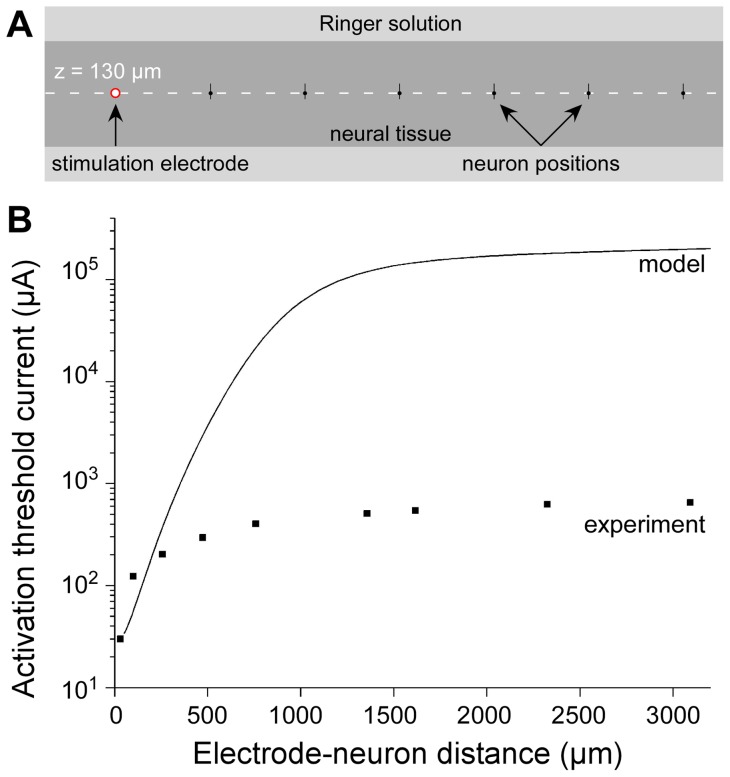
Modeling prediction of activation threshold currents.
A: Simulated TCs were computed for different positions of Neuron 1 (see Figure 2) along a line passing 50 µm above the tip of the stimulation electrode. B: Theoretical TCs (continuous line) were found to be close to experimental TCs (square symbols) for short electrode-neuron distances (typically below 250 µm). For increasing distances, theoretical TCs reached levels several orders of magnitude above experimental ones (note the logarithmic scale).